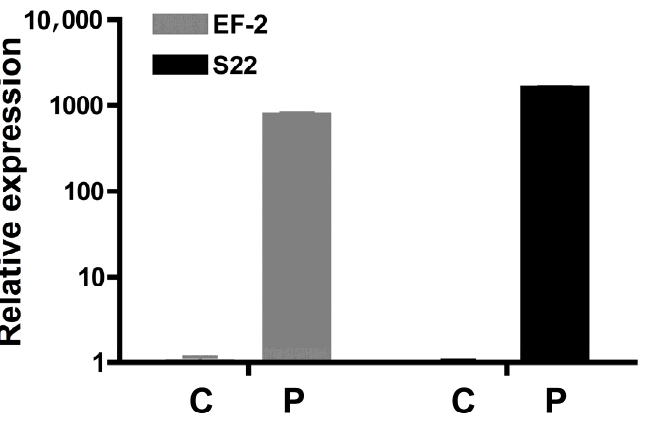
Figure 3. Comparison of expression level of Efe-afpA in culture (C) with expression in planta (P) relative to expression levels of two reference genes, elongation factor 2 (EF-2; gene model EfM3.021210) and 40S ribosomal protein S22 (S22; gene model EfM3.016650). The y-axis is a logarithmic scale.